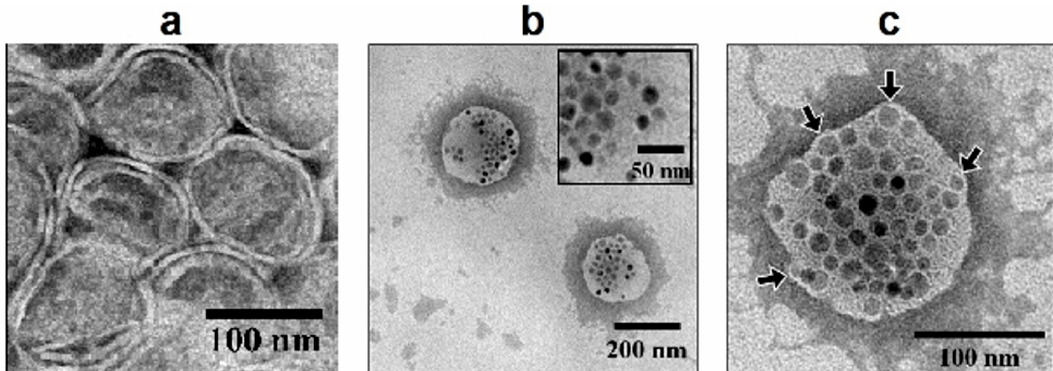
Figure 1. Representative TEM micrographs of ( a ) cisplatin-loaded liposomes (Cis-Ls) and ( b , c ) cisplatin-loaded magnetic liposomes (Cis-MLs). All samples were negatively stained with 2% uranyl acetate solution. The inset represents an enlarged view of the magnetite nanoparticles contained in the liposome structure.